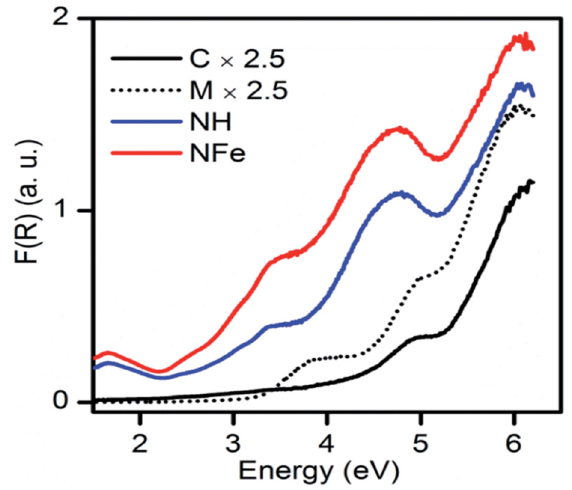
Figure 9. Diffuse reflectance spectra of synthetic and natural zeolites. Reprinted from Ref. [13].